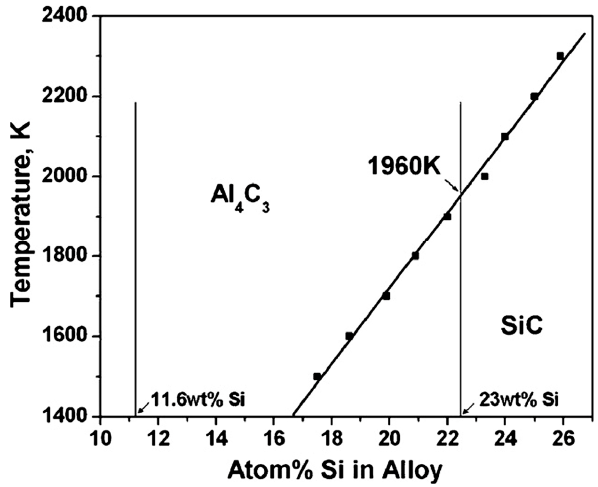
Figure 13. The chemical composition dependence of formed intermetallics on Si weight percent and fabrication temperature [131]. (Reproduced with permission from [131], Elsevier, 2009.)